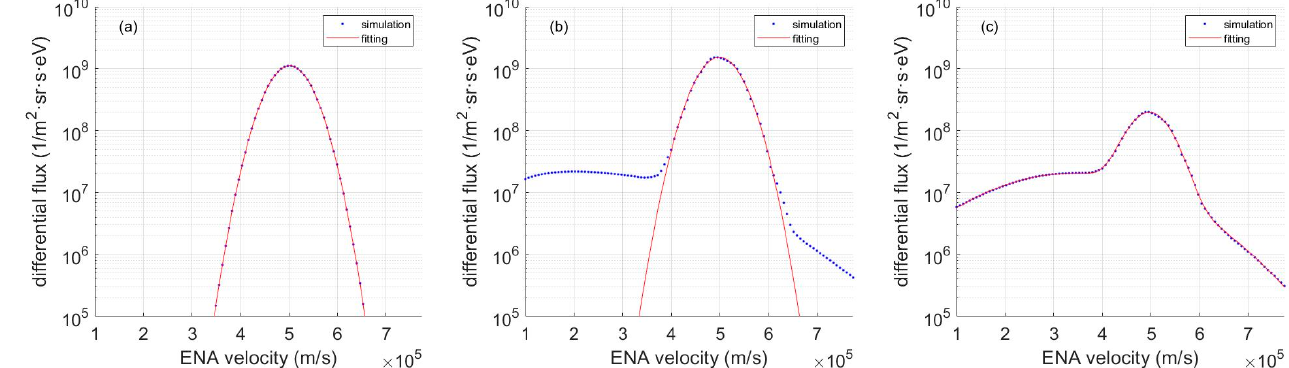
Figure 5. The simulated H-ENA di ff erential fl ux and Gaussian fi tt ing. The blue do tt ed curves rep- resent the simulated data, and the red curves represent the fi tt ing. ( a , b ) Fi tt ing of the single Gaussian represent the simulated data, and the red curves represent the fitting. ( a , b ) Fitting of the single function; ( c ) fi tt ing of the double Gaussian function. The observation positions are the same with Gaussian function; ( c ) fitting of the double Gaussian function. The observation positions are the same Figures 3 and 4 in the SW, MPR, and magnetotail, respectively. with Figures 3 and 4 in the SW, MPR, and magnetotail, respectively.